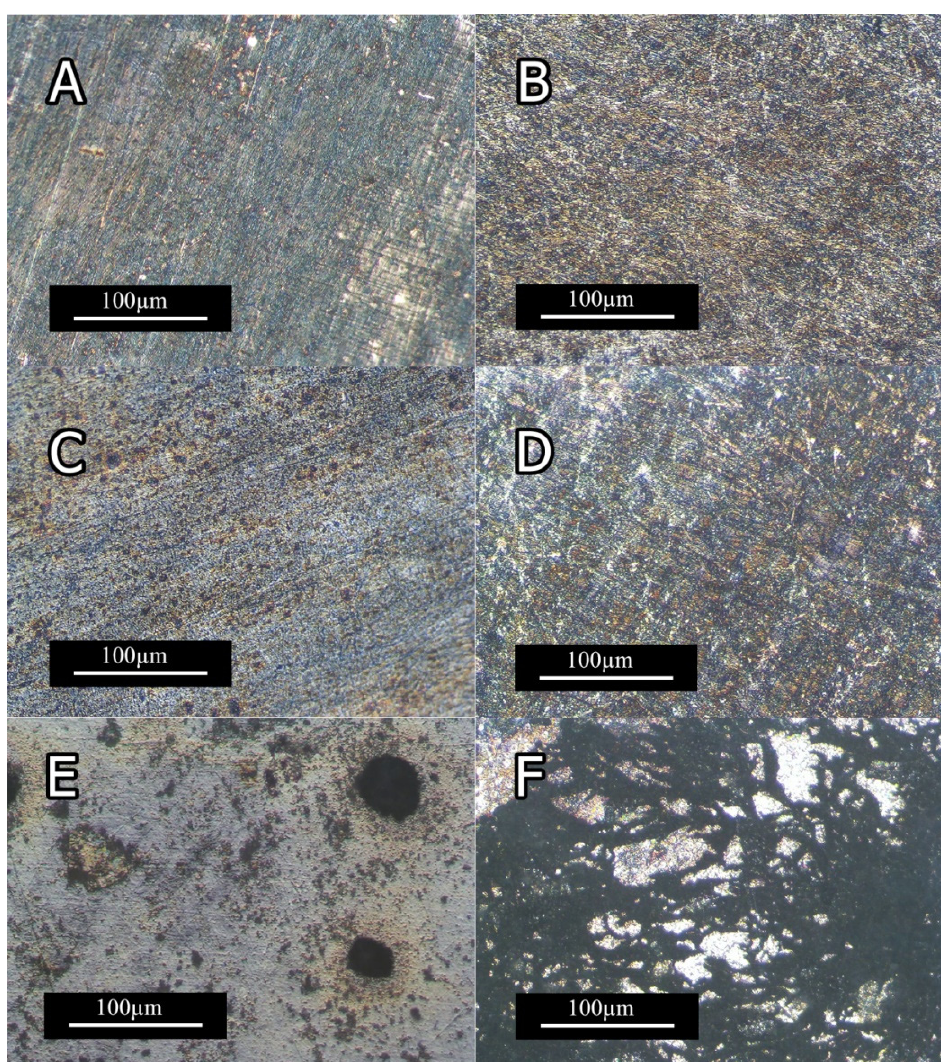
Figure 14. Optical micrographs of the samples’ surface after immersion in 3.5 wt.% NaCl solution ( A ) 0Ti after 10 min; ( B ) 0Ti after 2 h; ( C ) 0.15Ti after 10 min; ( D ) 0.15Ti after 2 h; ( E ) 1.5Ti after 10 min; and ( F ) 1.5Ti after 2 h.